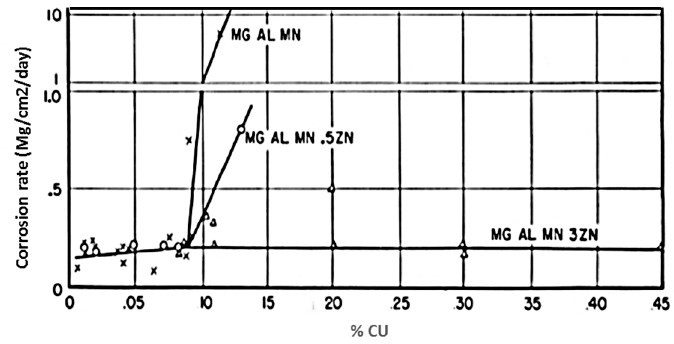
Figure 22. Effect of Cu in a Mg-Al-Mn-Zn alloy. Modified from [129].